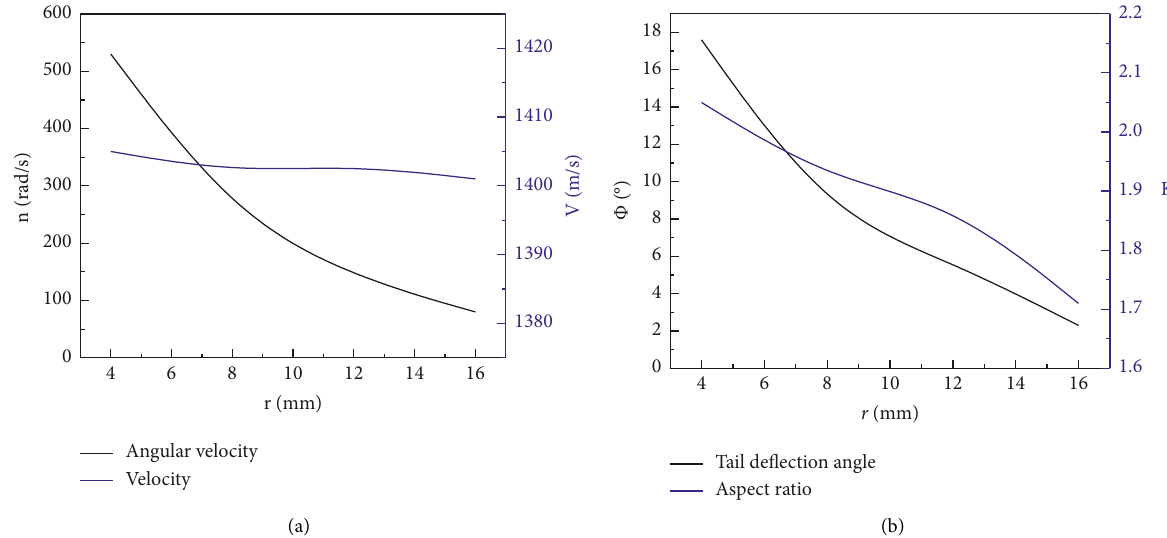
Figure 23: Variations of the angular velocity, axial velocity, tail fin tilt angle, and aspect ratio with the spherical arc radius. (a) Variations of the angular and axial velocities with the spherical arc radius (b) Variations of the tail fin tilt angle and the aspect ratio with the spherical arc